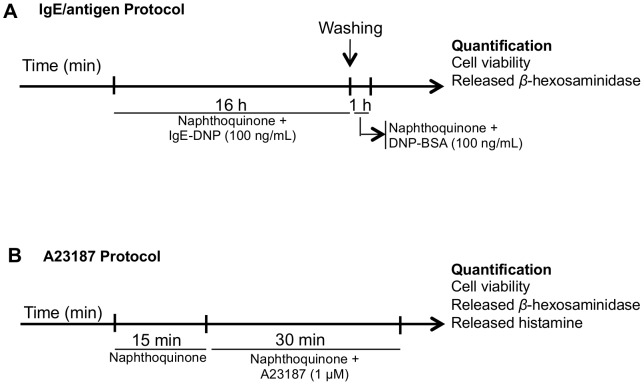
Schematic representation of protocols of RBL-2H3 basophils' degranulation assays using IgE/antigen (A) or calcium ionophore (A23187) (B) as stimuli.